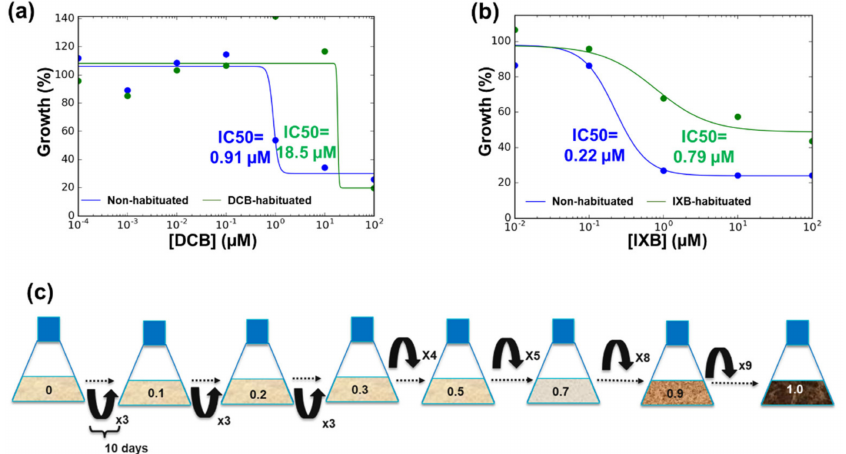
Figure 1. IC 50 graphs of non-habituated and habituated cells ( a , b ) and scheme showing the step-wise adaptation of the cell cultures to DCB and IXB 1 µ M (c). The IC 50 were calculated with the IC 50 Tool Kit (available at http://www.ic50.tk/index.html accessed date 15 July 2018) and visualized with the Multi-IC 50 Plotting Tool (available at http://www.ic50.tk/multiic.html accessed date 15 July 2018). Each subculture step in ( c ) lasted 10 days and was repeated for the indicated times (x number) before increasing the concentration (in µ M) of the inhibitors (indicated on the